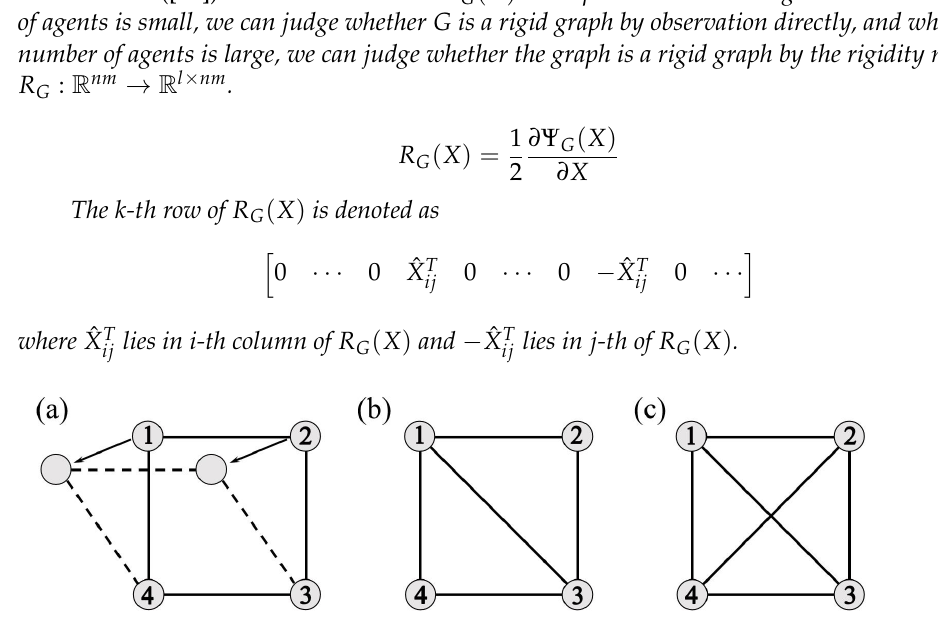
Figure 1. ( a ) Flexible frame. ( b ) Minimum rigidity graph. ( c ) Rigidity